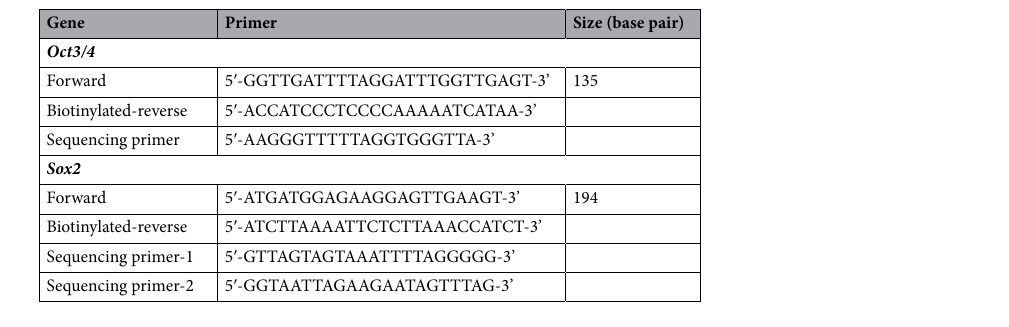
Table 2. Primers for